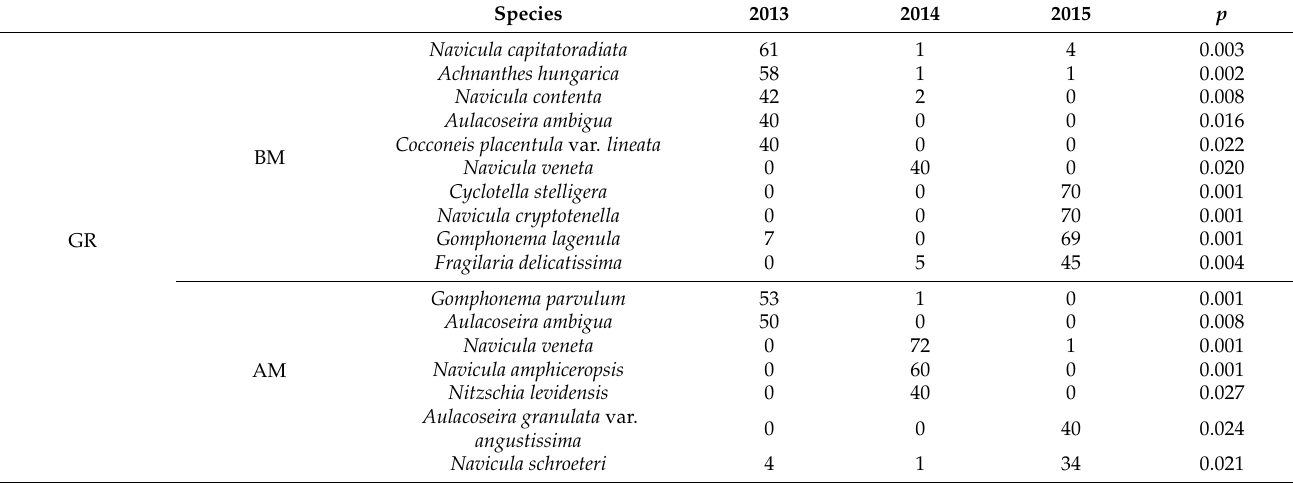
Table 5. Indicator species in Geumgang river (GR) and Mangyeonggang river (MR), Dongjingang River (DR), and Sapgyocheon stream (SS) of the Korean Peninsula from 2013 to 2015.